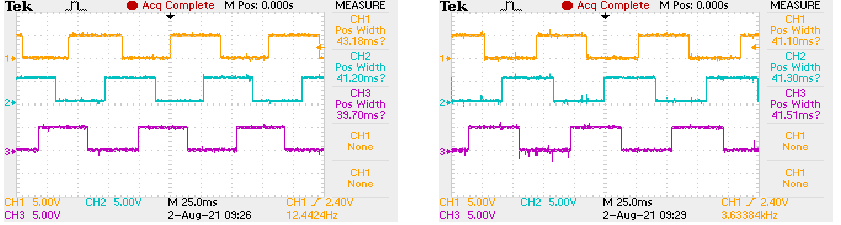
Figure 26. Oscillograms showing signals from Hall effect sensors installed in the engine ( left ) and from the outer target ( right